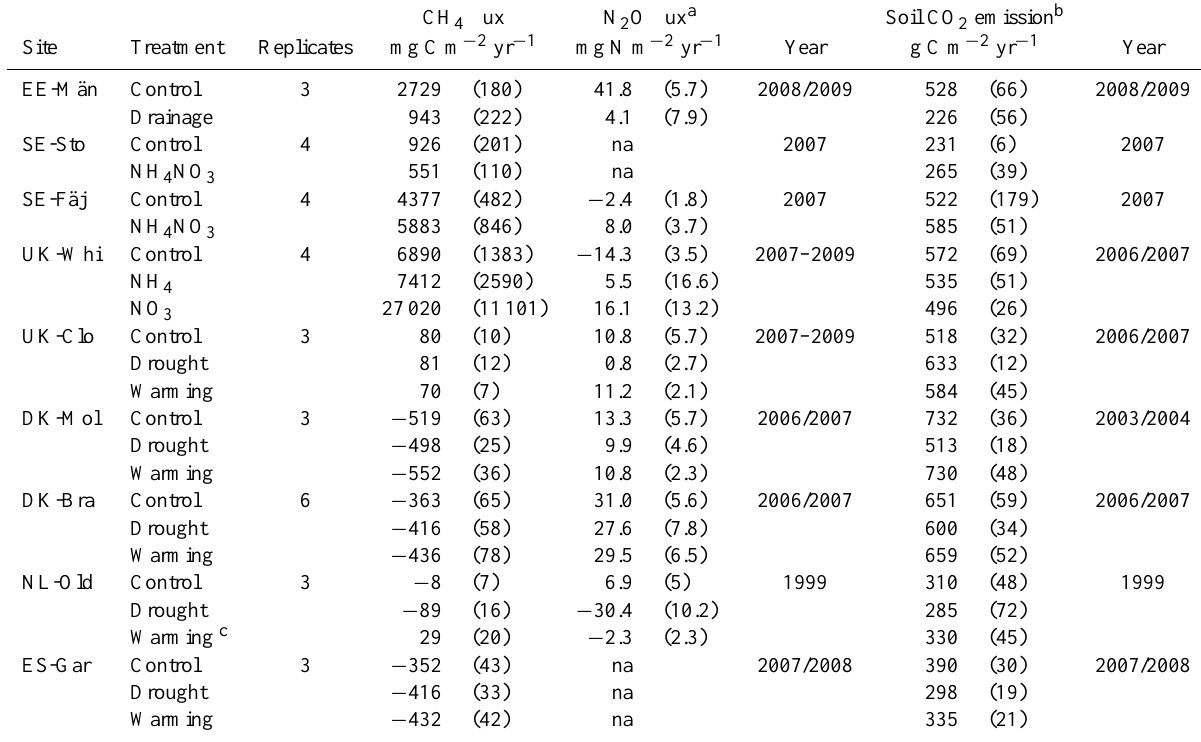
Table 3. Annual cumulative CH 4 , N 2 O and soil CO 2 fluxes at the nine experimental sites depending on treatment (means; SE in brackets). Number of replicated plots and year of measurement (either one or two years) are also indicated.